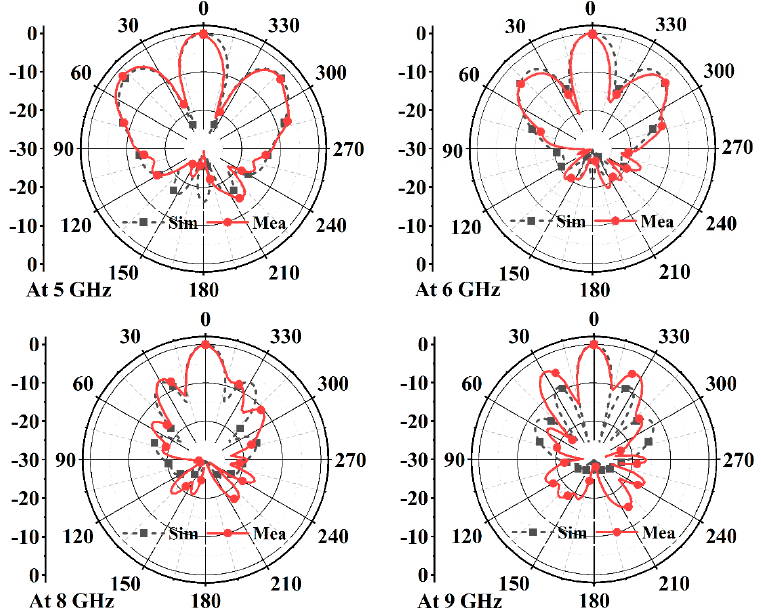
Figure 16. Simulated and measured radiation patterns of the proposed antenna at different frequen-